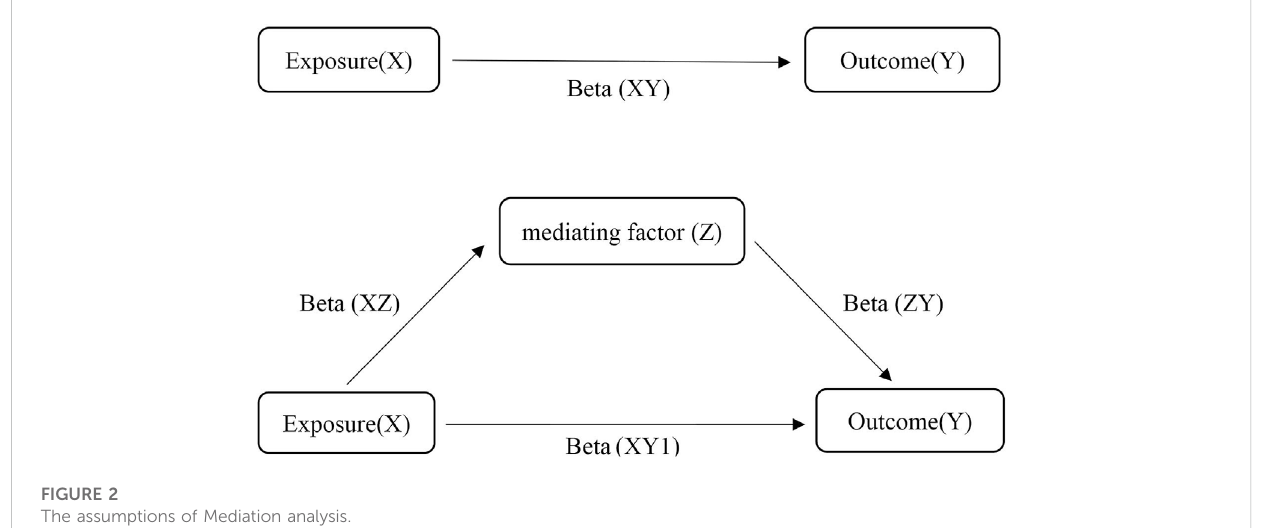
FIGURE 2 The assumptions of Mediation